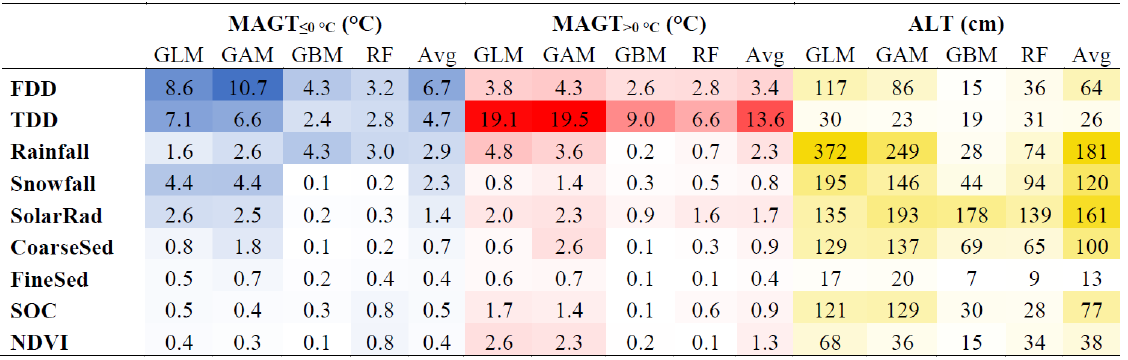
Table 2. The effect size of individual predictors and their four-model averages (see Sect. 2.2 for abbreviations) in the original scale of the responses; (mean annual ground temperature) MAGT is in degrees Celsius and active-layer thickness (ALT) is in